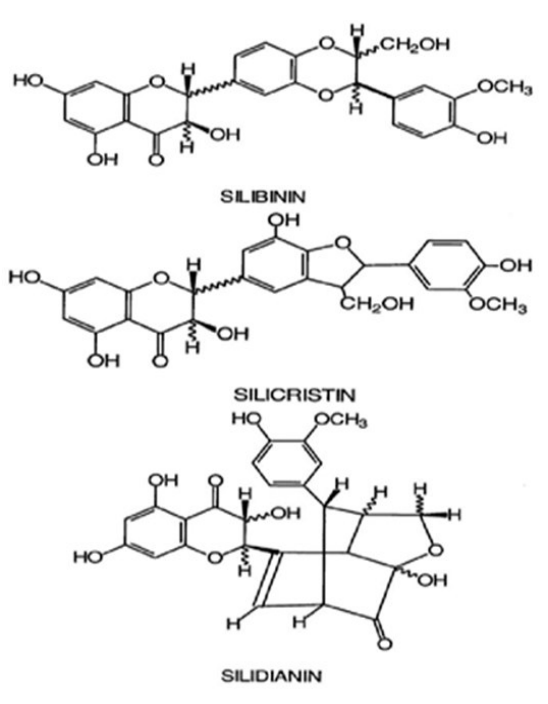
Fig. 1. Chemical structure of the most important ingredients of S.